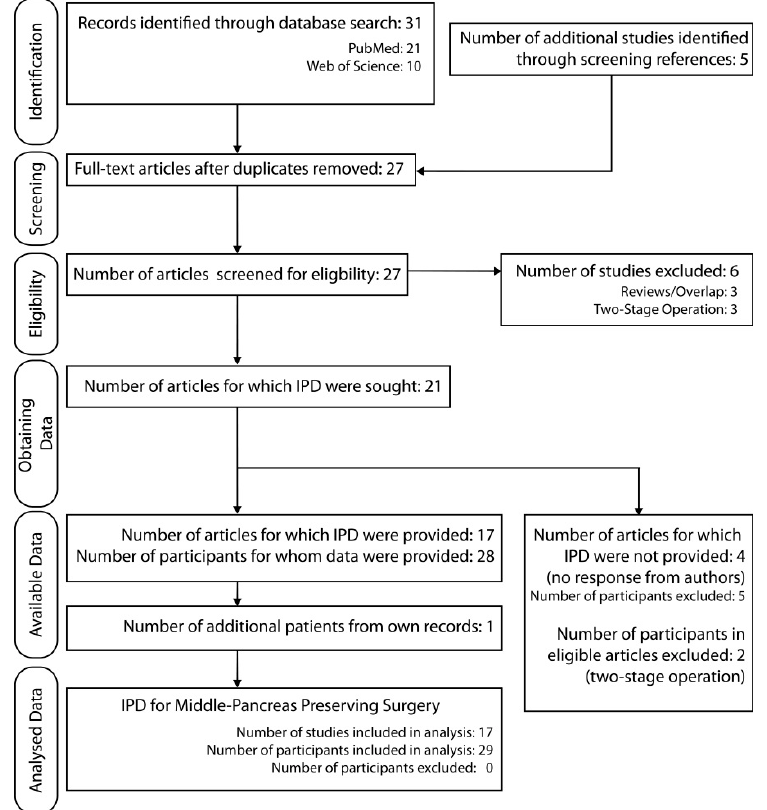
Figure 2. PRISMA-IPD flowchart for literature review and generation of MPP dataset. IPD: individual patient data. Table 1. Articles reporting MPP for which individual patient data (IPD) was sought, showing pathological indication and dignity of patients who received single-stage MPP and for whom IPD was obtained; also showing 1 MPP patient from the Heidelberg University Hospital database.